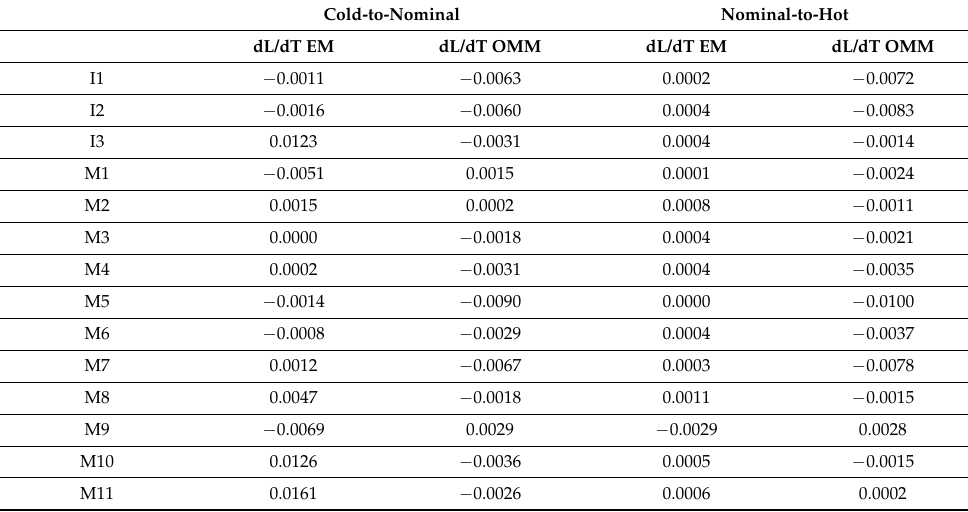
Table 6. JPSS-2 VIIRS radiometric sensitivity to temperature change of the instrument. Columns 2 and 3 are for electronics module and optomechanical module temperature sensitivities for the TVAC transition from cold to nominal plateaus and columns 4 and 5 are the corresponding sensitivities for the nominal to hot plateau transition.